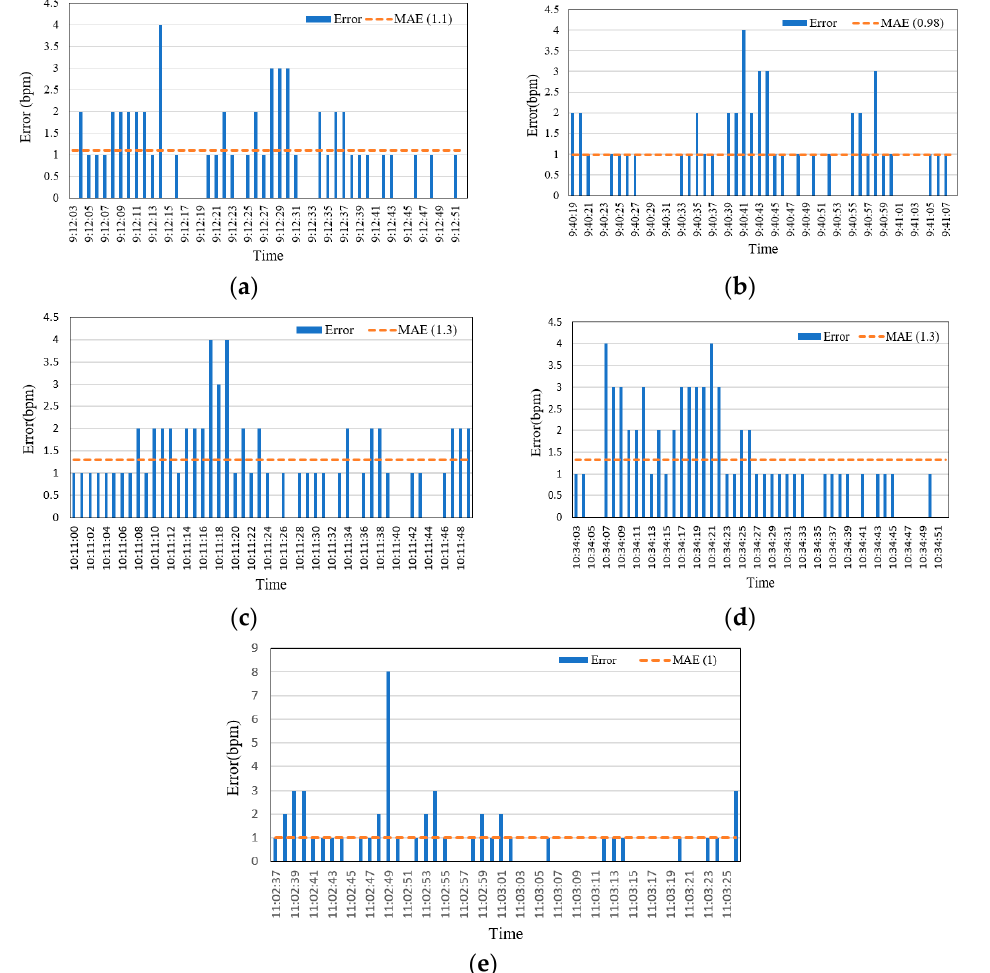
Figure 11. Mean absolute error values for heart rate data from five young volunteers of different ages: